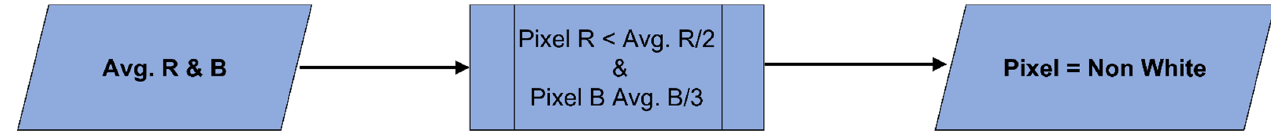
6 of 13 Figure 3. Workflow of step 1: calculations of white pixels using the R and B pixels average values.